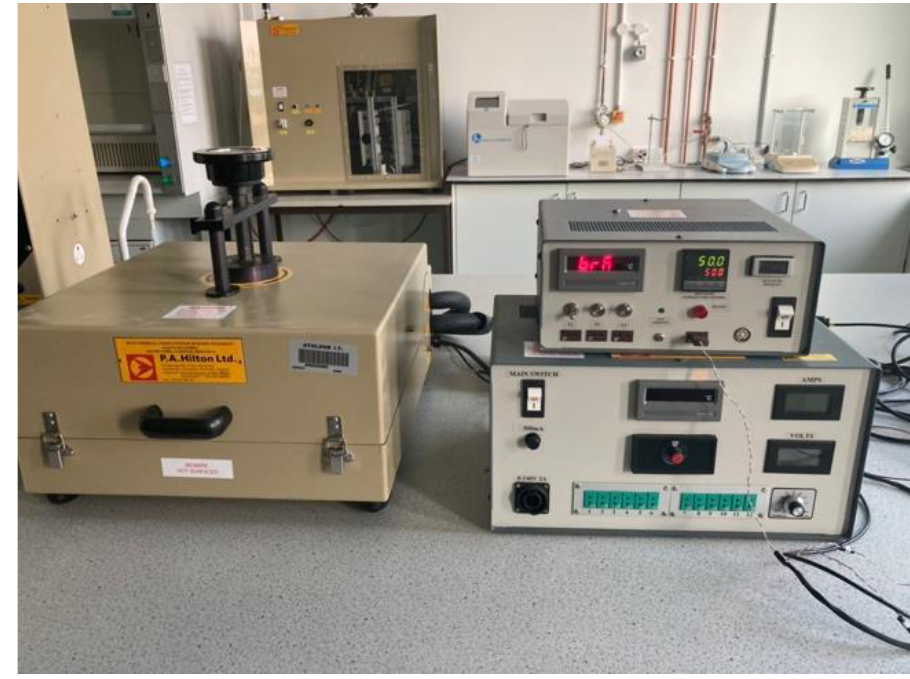
Figure 6. Equipment used to measure thermal conductivity.